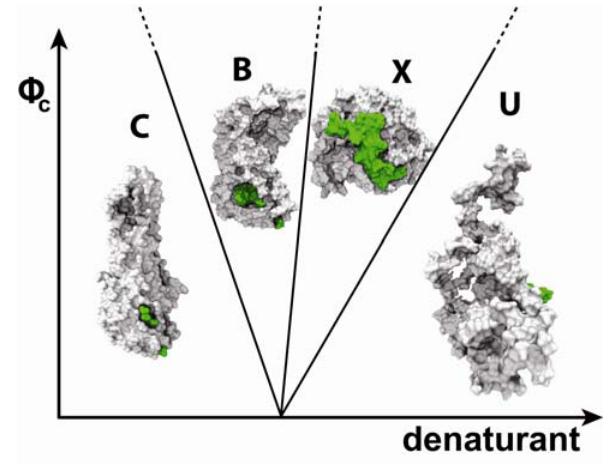
Figure 4. Phase diagram of VlsE conformations as a function of the volume fraction of , and ambient perturbation (thermal or chemical denaturation). The crowding agents, φ c structures shown are surface plots of high-resolution structures created from low-resolution configurations. The antigenic region, IR6, is shown in